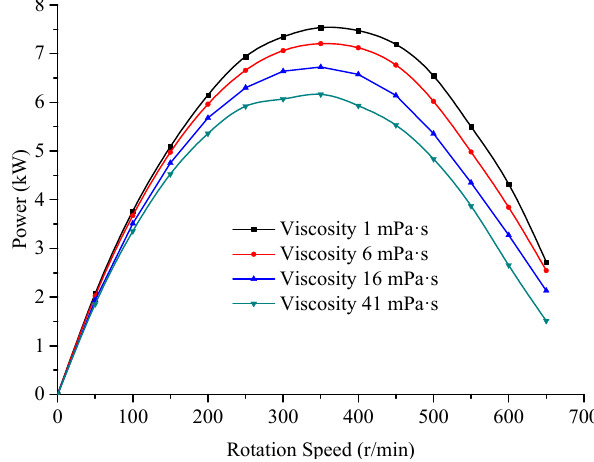
Figure 13. Power vs. speed curves for different viscosities.